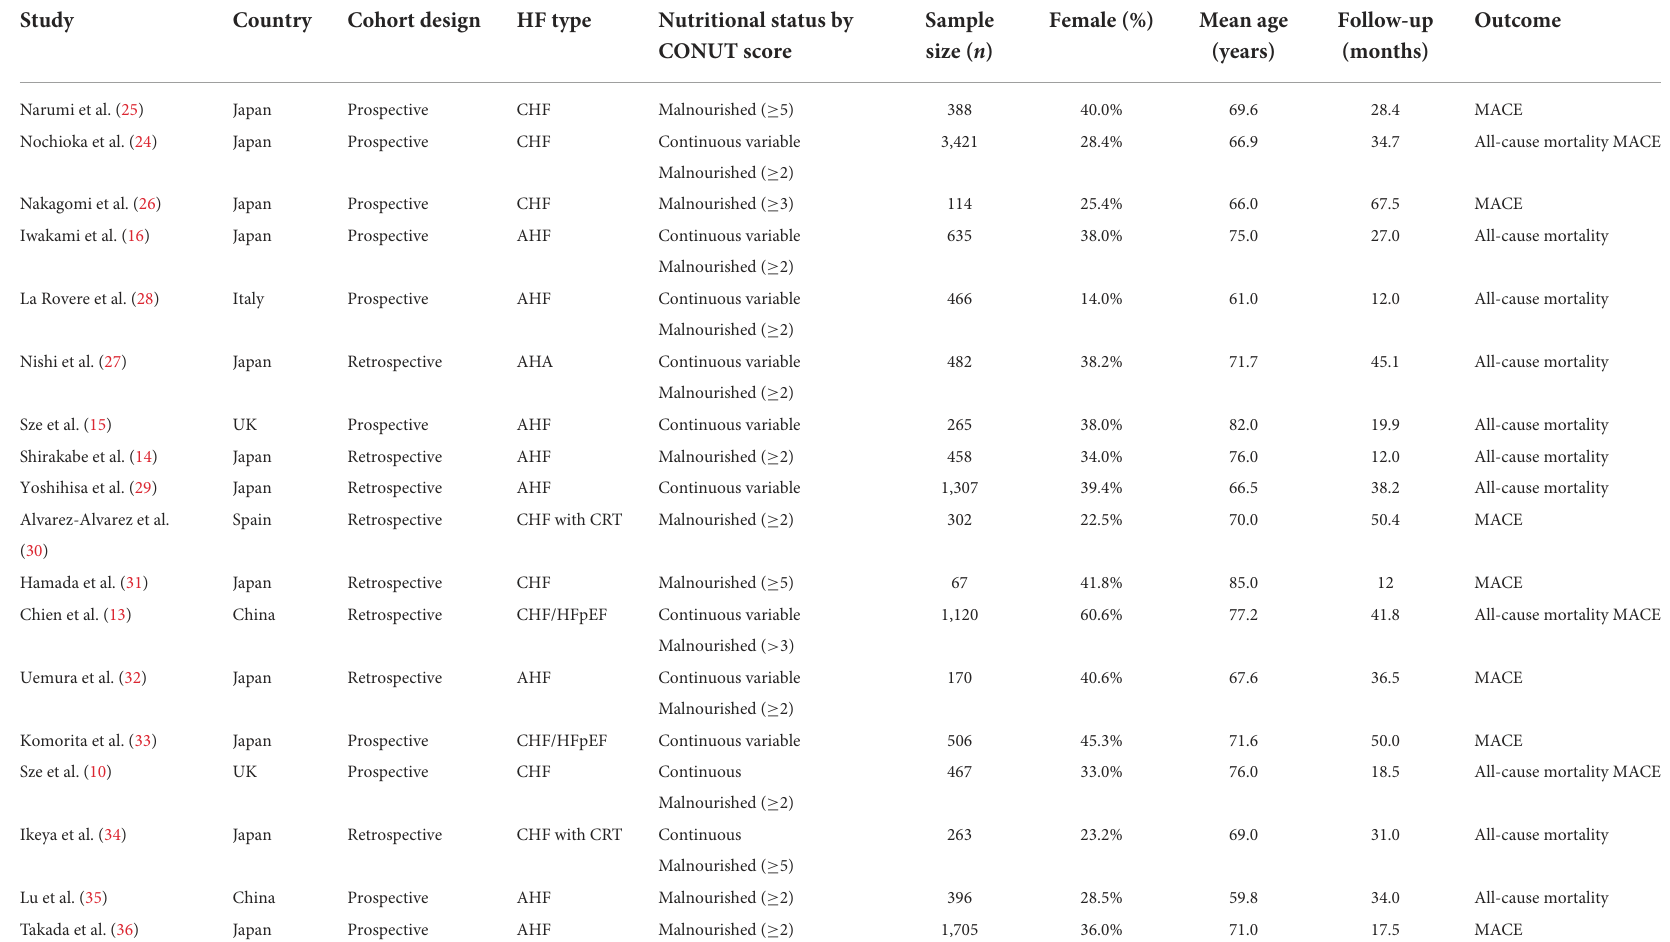
TABLE 2 Baseline characteristics of the included